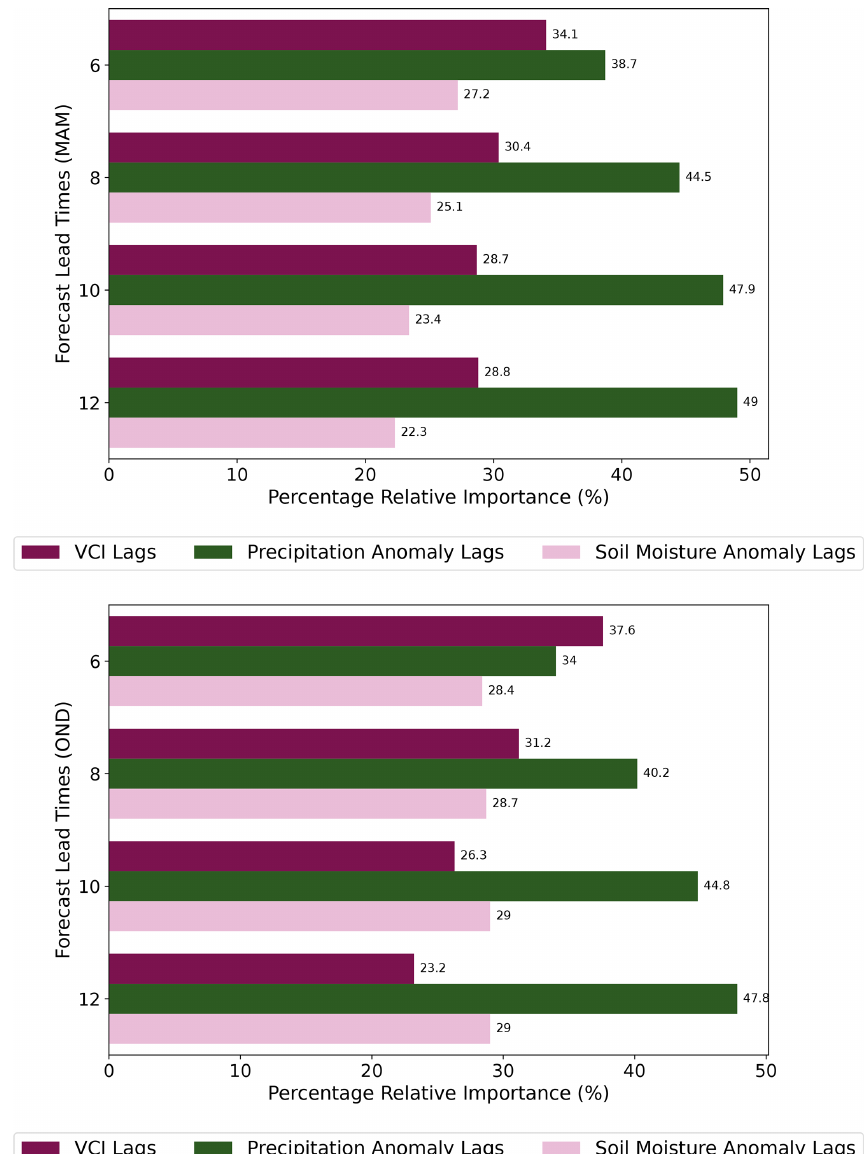
Figure C1. Cumulative lag relative importance plots for counties for the MAM and OND